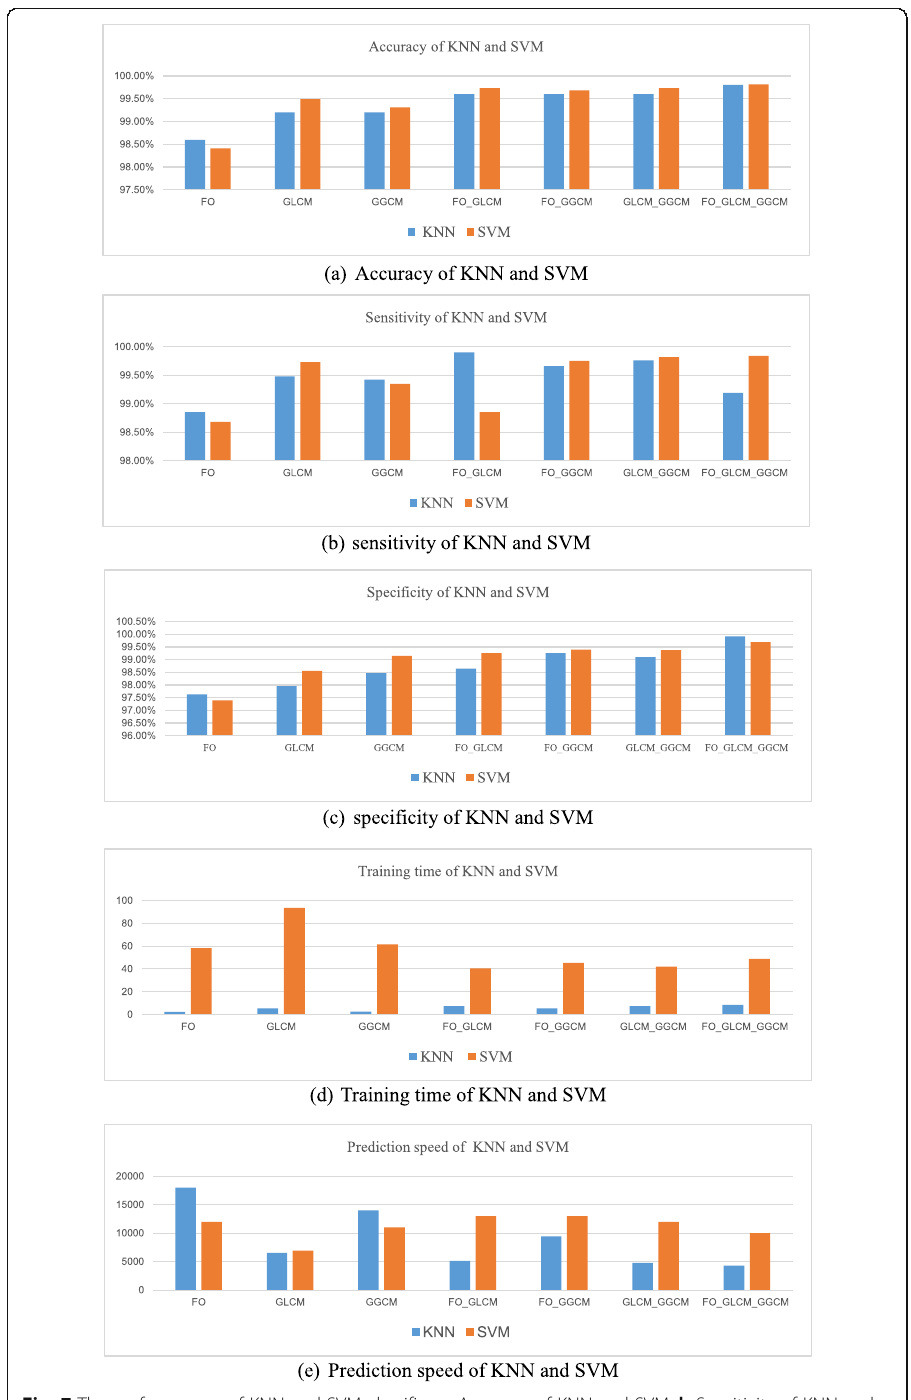
Fig. 7 The performances of KNN and SVM classifier. a Accuracy of KNN and SVM. b Sensitivity of KNN and SVM. c specificity of KNN and SVM. d Training time of KNN and SVM. e Prediction speed of KNN and